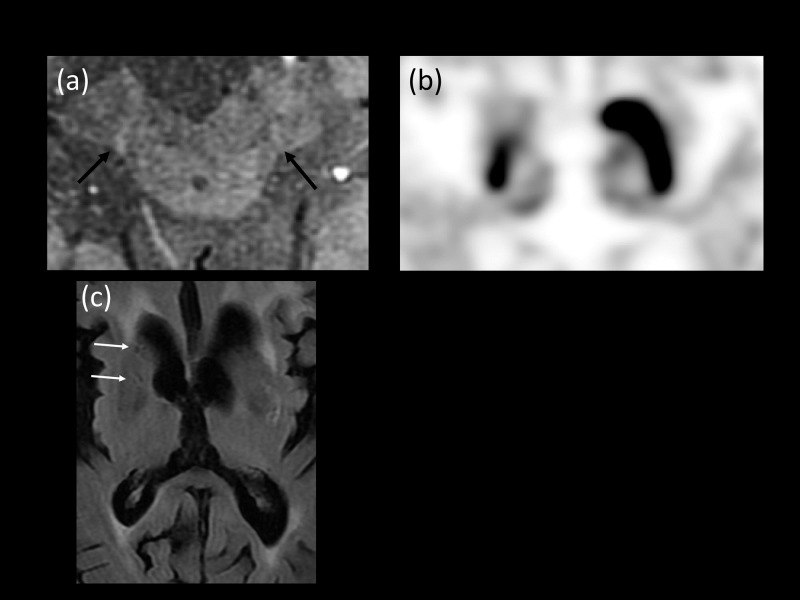
A 76-year-old woman with right hand tremor.(a) High-resolution susceptibility-weighted imaging (HR-SWI) revealed normal dorsolateral hypersignal intensity in bilateral substantia nigra pars compacta (Black arrows, diagnostic confidence 60; poor mineralization involved both substantia nigra, which limited the evaluation of bilateral NG1). (b) FP-CIT positron emission tomography (PET) showed decreased binding in the right side of the putamen. (c) Fluid attenuated inversion recovery (FLAIR) imaging revealed miniscule, old lacunar infarctions in the right caudate head and putamen (indicated by white arrows). The patient was assigned to the disease control group and the final clinical diagnosis was vascular Parkinsonism.